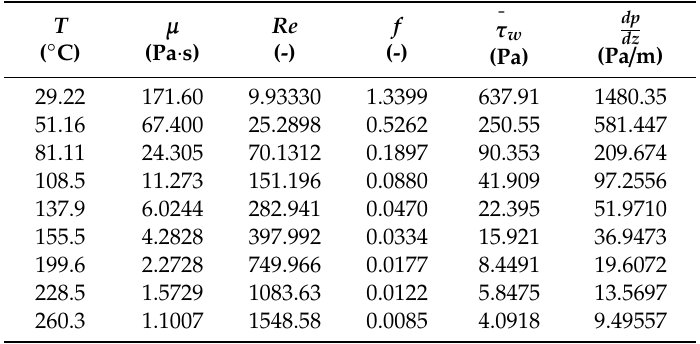
Table 9. Values of the fluid dynamic parameters obtained in the simulations with β = 0.06 and N = 12.